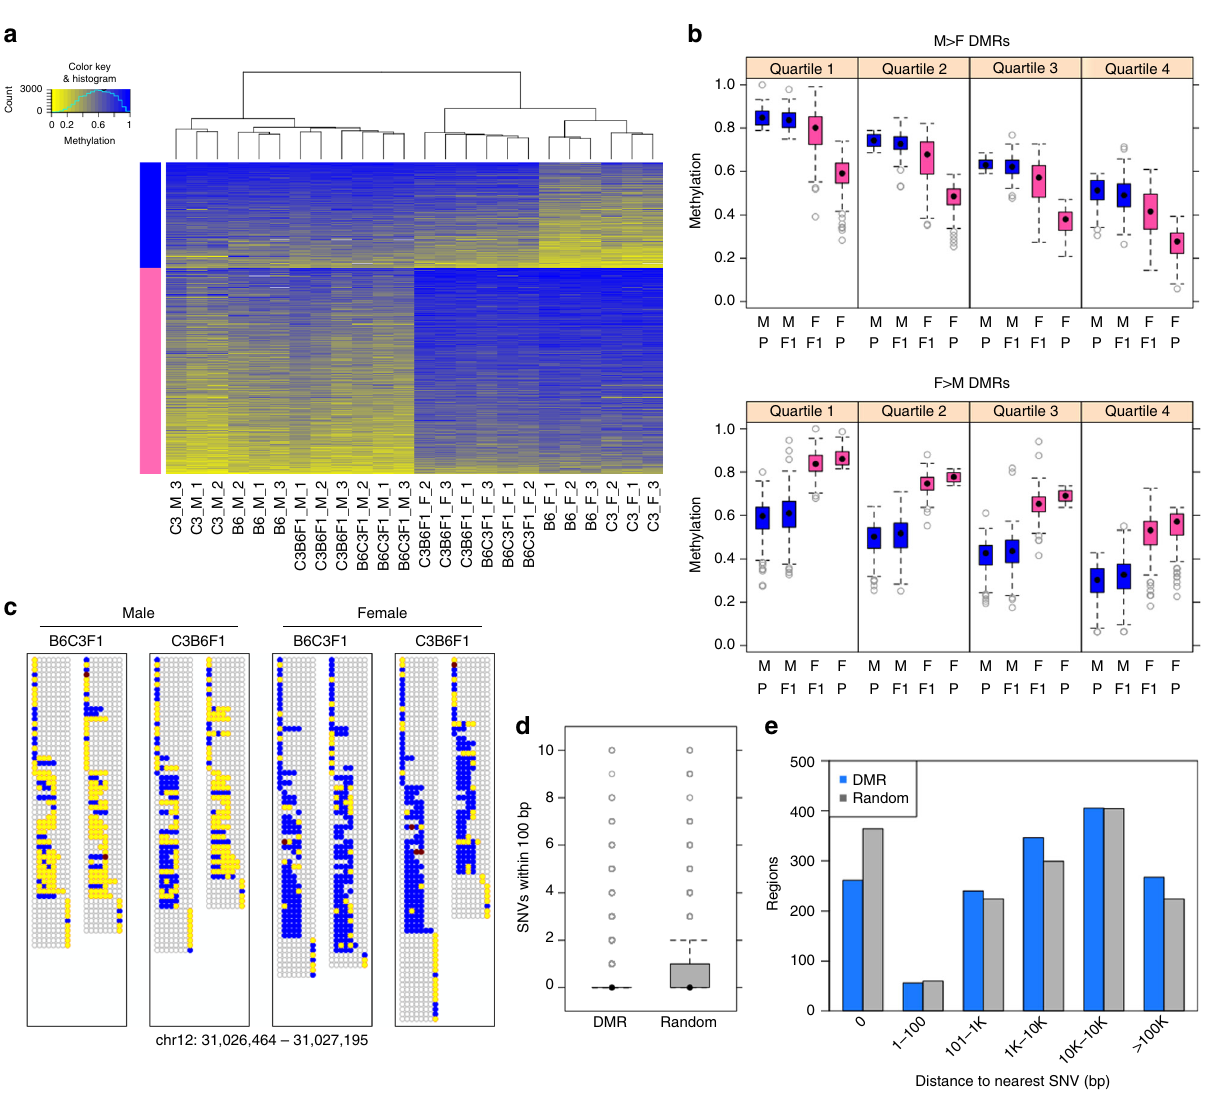
Fig. 6 Recapitulation of DNA methylation patterns at DSS sex-DMRs in F1 progeny varies by DMR polarity. a Heatmap view of weighted methylation scores per male-vs.-female DSS DMR ( N = 1575) per animal. Hierarchical clustering of animals performed by R package “ amap ” (hcluster with method = euclidean and link = average). DMRs were split by direction (M > F: blue bar, or F > M: pink bar) then sorted by average methylation score over all 24 animals. b Distribution of average weighted methylation scores, with DMRs split into quartiles according to decreasing methylation score of the hypermethylated parental sex. Animals are grouped according to both sex (M, F) and genotype group (P = parental B6 or C3, F1 = offspring B6C3F1 or C3B6F1). c Methylation in F1 progeny at the read level for an exemplar DSS DMR, organized as described for Fig3C. d Number of SNVs local to DMRs ( N = 1575), compared to size-matched random genomic regions ( N = 1575). e Distribution of distance to the nearest SNV for DMRs ( N = 1575) or size-matched random genomic regions ( N = 1575). Distance = 0 indicates that at least one SNV is found within a region of a given type. In the box-and-whisker plots, the box depicts the 25th to 75th percentiles, the black dot is the median, the whiskers extend to data points up to 1.5*IQR beyond the box, and open gray circles are data points outside the whisker